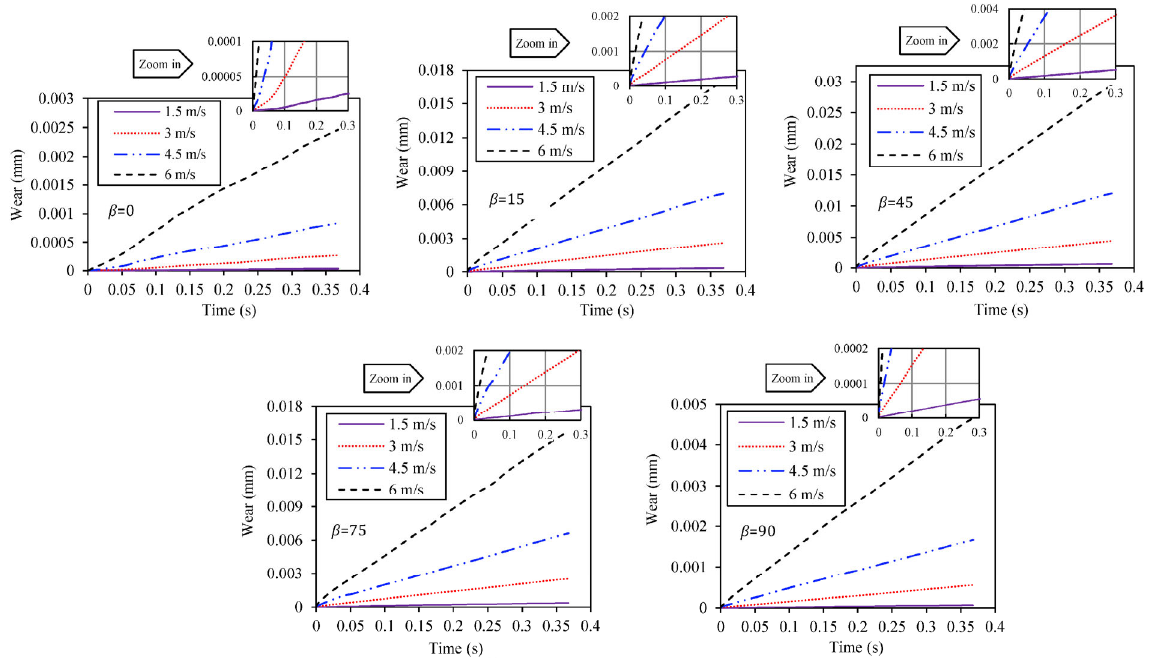
Fig. 14 Variation of the erosive wear versus time (distance) for different values of the speed and sample angle (particle diameter is 0.6 mm). Note: the vertical axes are not in the same